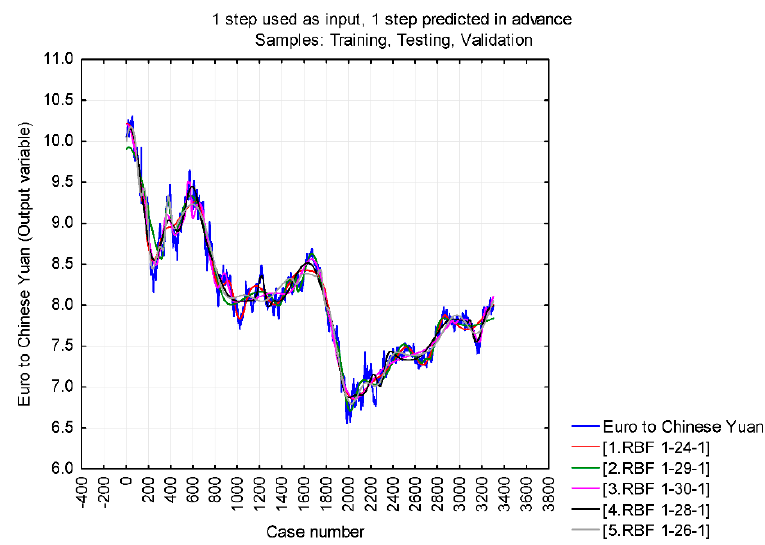
Figure 4. Line graph—development of the Euro to Yuan exchange rate predicted by neural networks in comparison with the actual exchange rate in the monitored period. (Source: Own processing.)